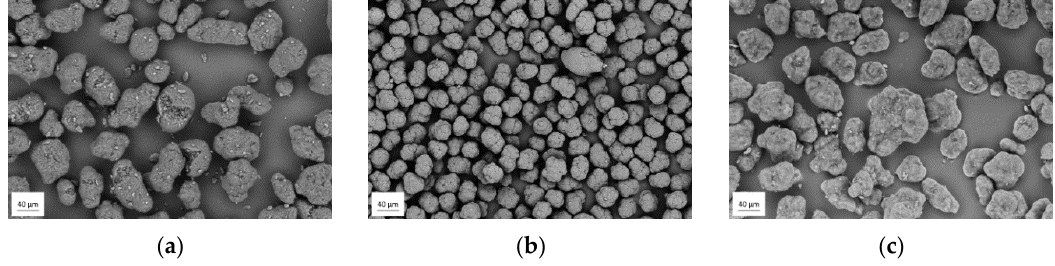
Figure 2. SEM images of powder particles ( a ) PA2200, ( b ) PA12 Smooth, ( c ) PA12 Black.